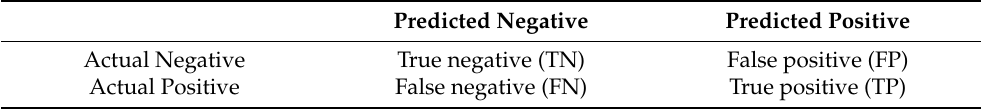
Table 7. Confusion Table 7 . Confusion matrix .